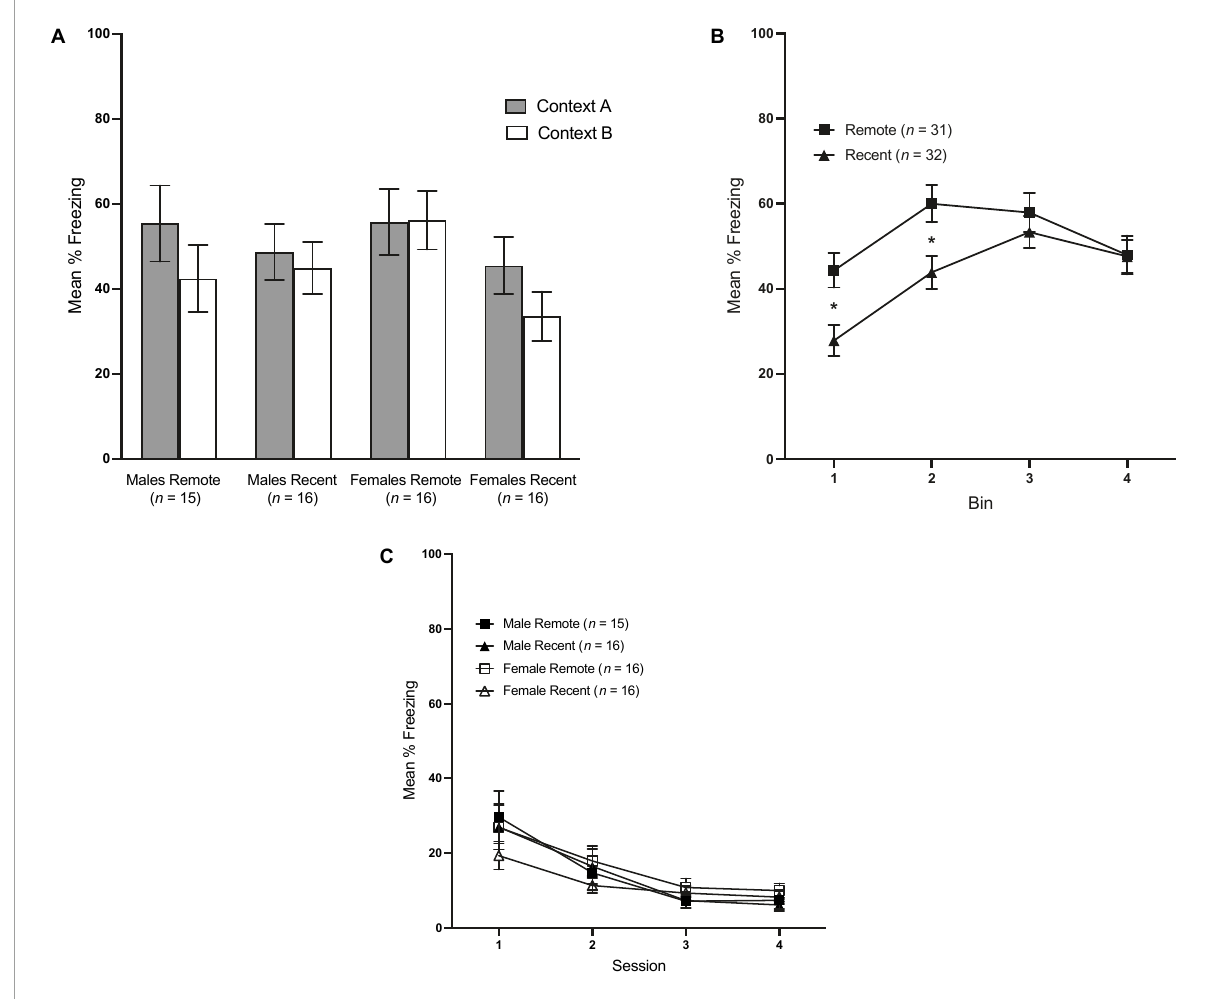
FIGURE3 (A) Mean percent freezing ( ± SEM) in Context A vs. Context B for all groups during the context retrieval test. (B) Mean percent freezing ( ± SEM) during the context tests across 4 1-min bins, collapsed across context and sex. (C) Mean percent freezing ( ± SEM) during sessions 1–4 of Context B Re-exposure. *Indicates significant with p < 0.05.